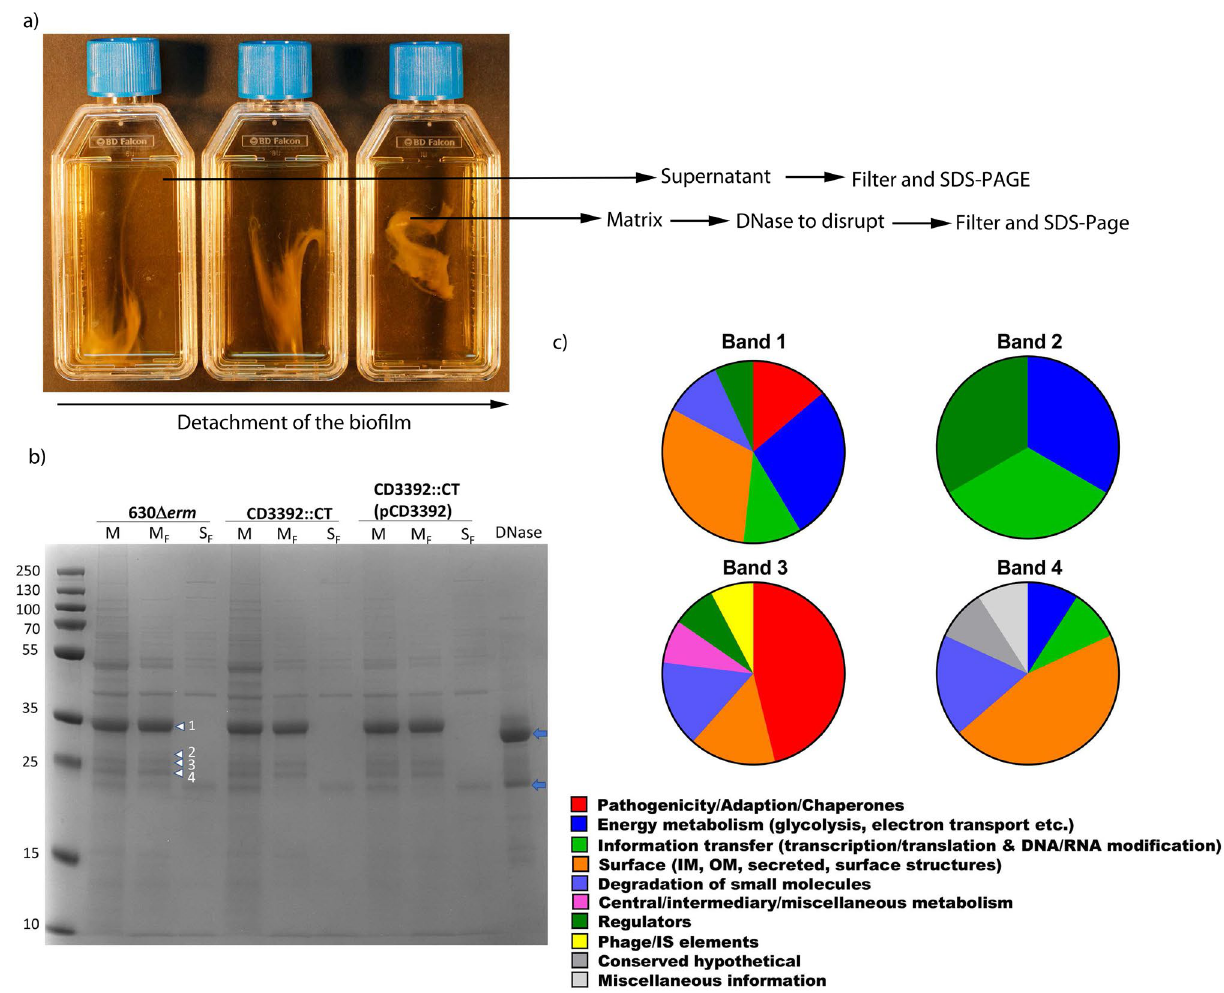
Figure 6. Analysis of the biofilm matrix and planktonic fractions. ( a ) Separation of the biofilm matrix and supernatant (planktonic fraction). After the biofilm matrix was detached from the bottom of the TC flask, the biofilm matrix was disrupted by the addition of DNase (100 µg/mL). ( b ) SDS-PAGE electrophoresis of the Biofilm matrix after DNase processing (M), filtered biofilm matrix (M F ), compared to the filtered planktonic fraction (S F ), and DNase control. The arrows on the left label the bands (1–4 top to bottom) sent for LC–MS/ MS from strain 630∆ erm , the blue arrows indicate the major and minor DNase band within the DNase control lanes. ( c ) Protein classification of the bands 1–4 presented in pie charts, with the percentage normalized total spectra. Colour codes indicate different functional classifications in accordance with the Riley